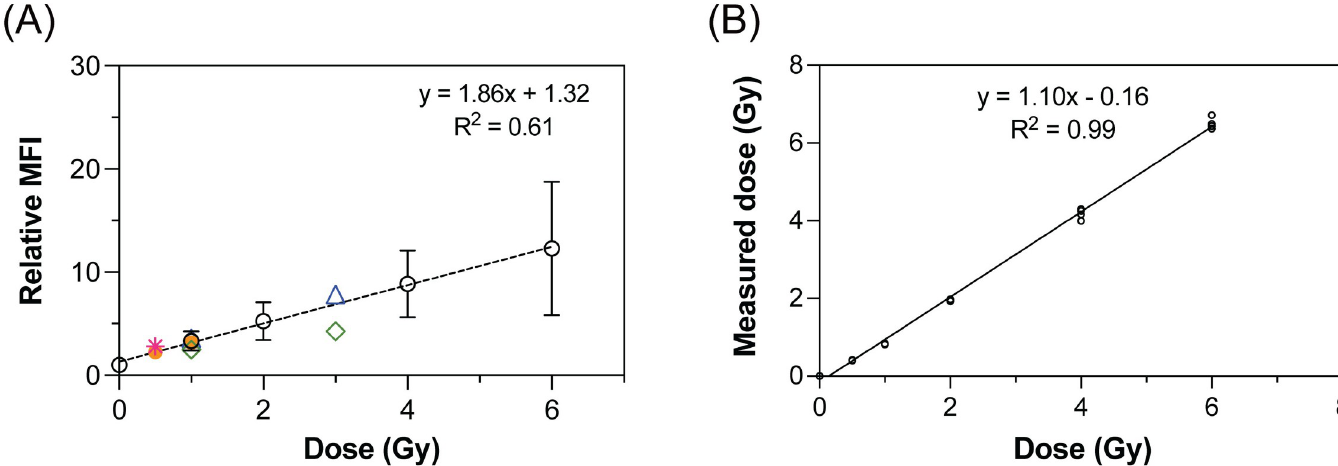
Fig 7. Blind testing of dose response curve. (A) flow cytometry and (B) physical dosimeter (nanoDots TM ). Colored symbols in open triangle, open diamond, closed circle and asterisk represent data obtained from the blind tests conducted on different dates. The same symbol at different selected doses in (A) corresponds to the same donor.